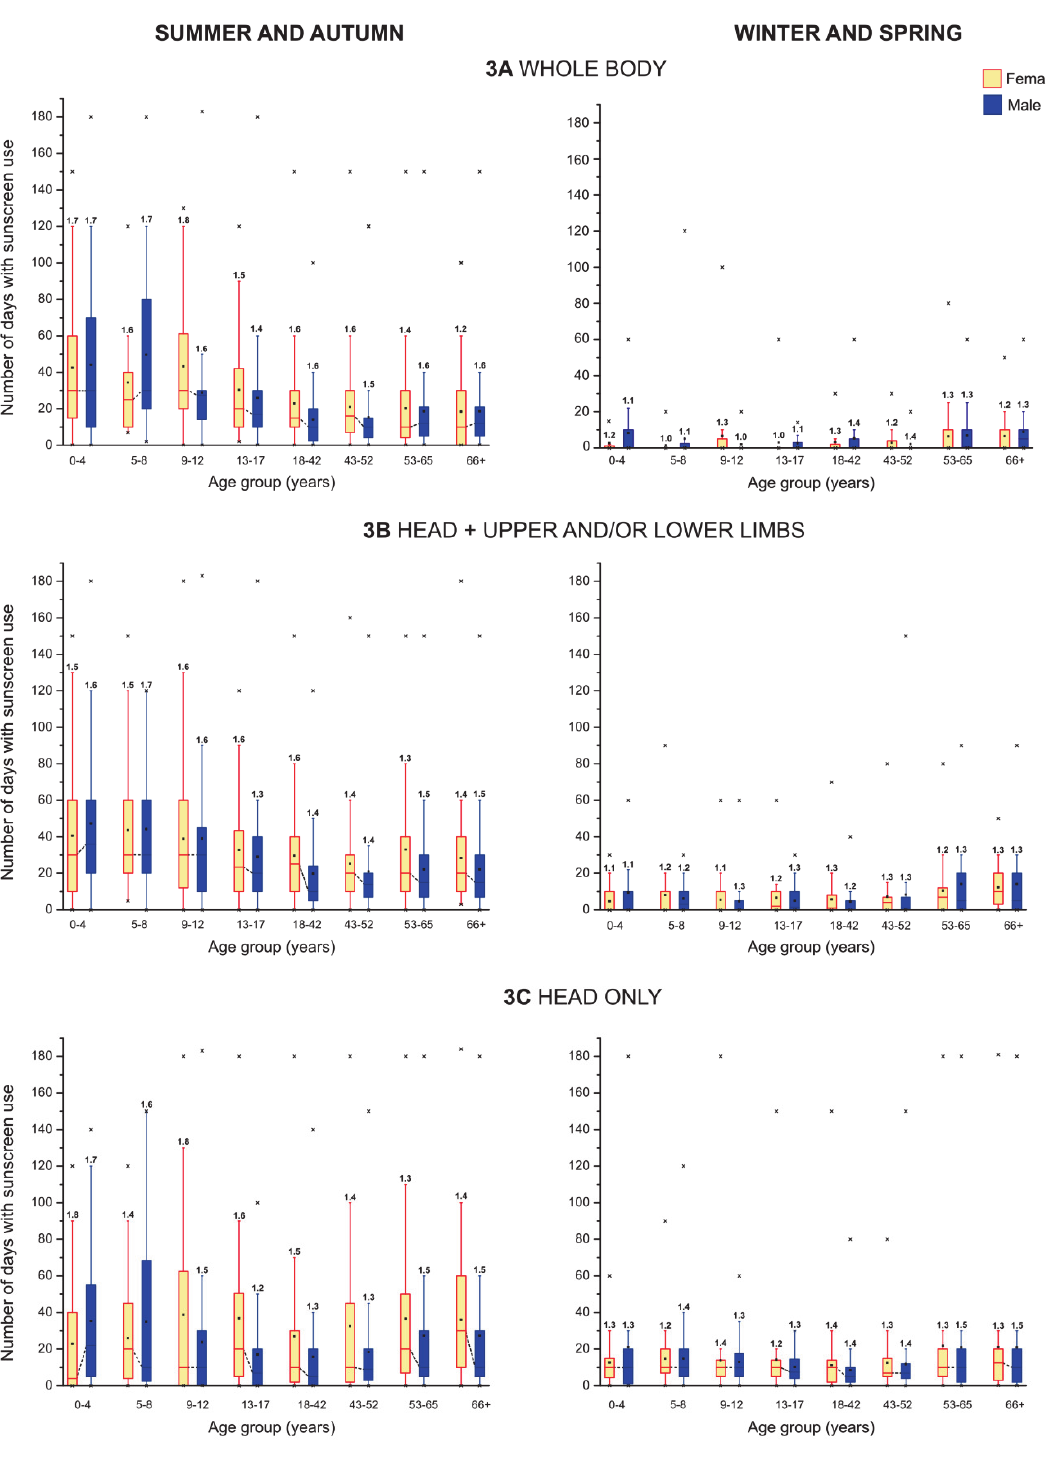
Figure 3. Distributions of frequency of sunscreen use to different body areas across age and gender groups. In each box plot, the lower and upper edges of the box represent the 25th percentile and the 75th percentile, respectively, the square indicates the mean, and the solid horizontal line the median. For better comparison, the medians between genders within each age group are connected by a dotted line. The vertical lines represent the 5th and 95th percentiles of the respective distribution. Outliers are displayed as crosses. The mean (arithmetic) number of sunscreen applications per day is displayed above each